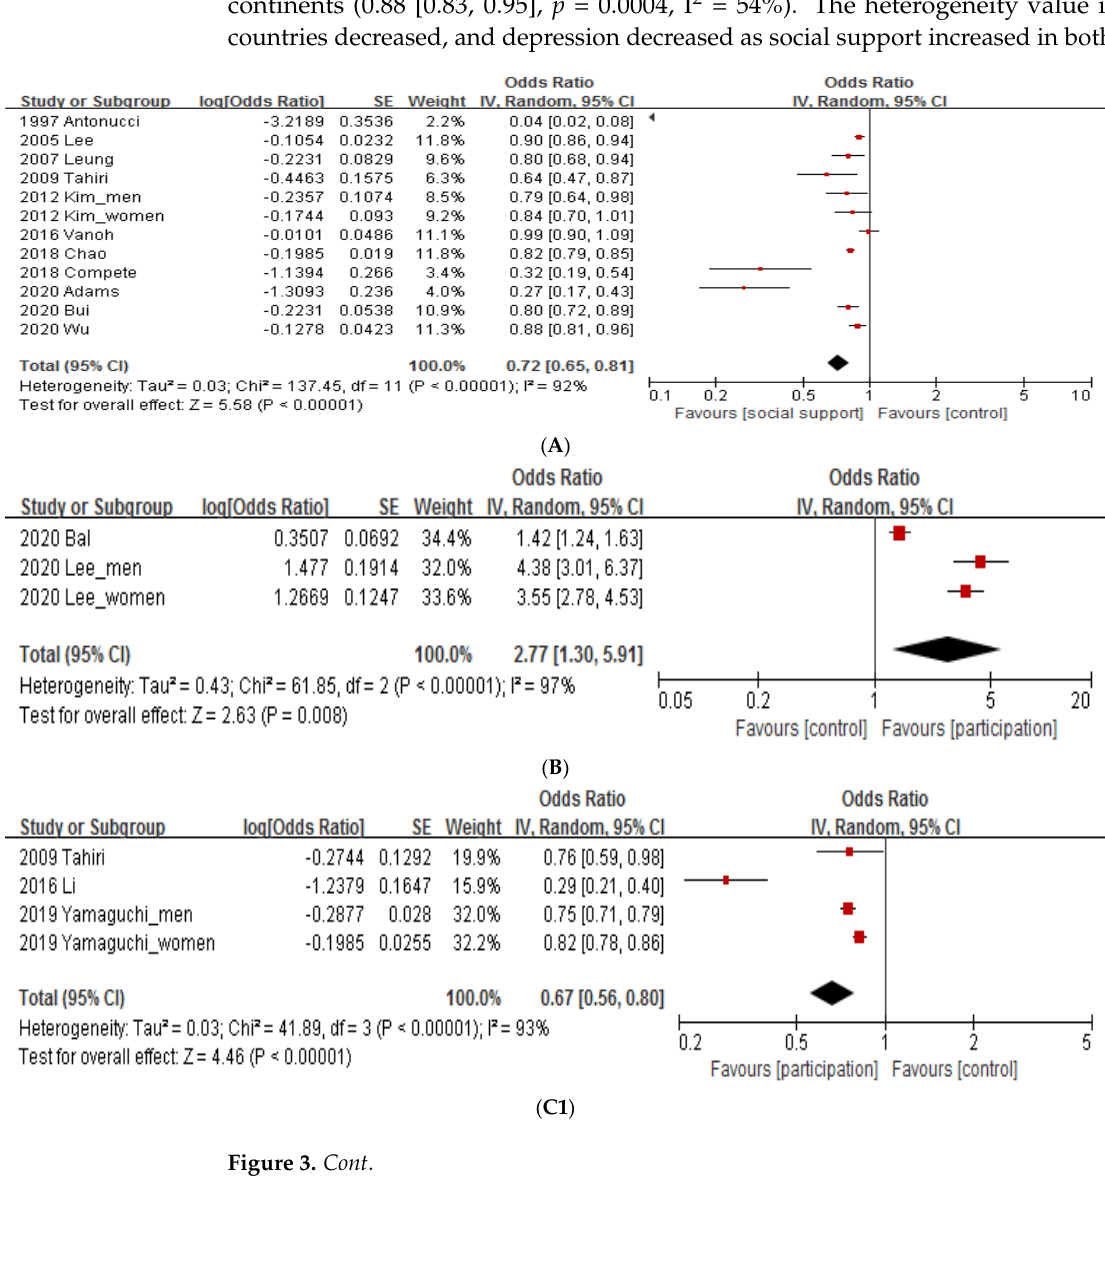
Figure 2. Quality assessment ( a ) Risk of bias graph; ( b ) Risk of bias summary.